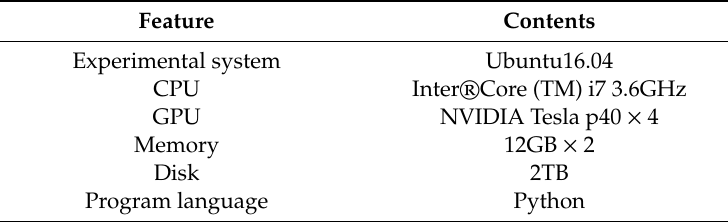
Table 6. Performance evaluation